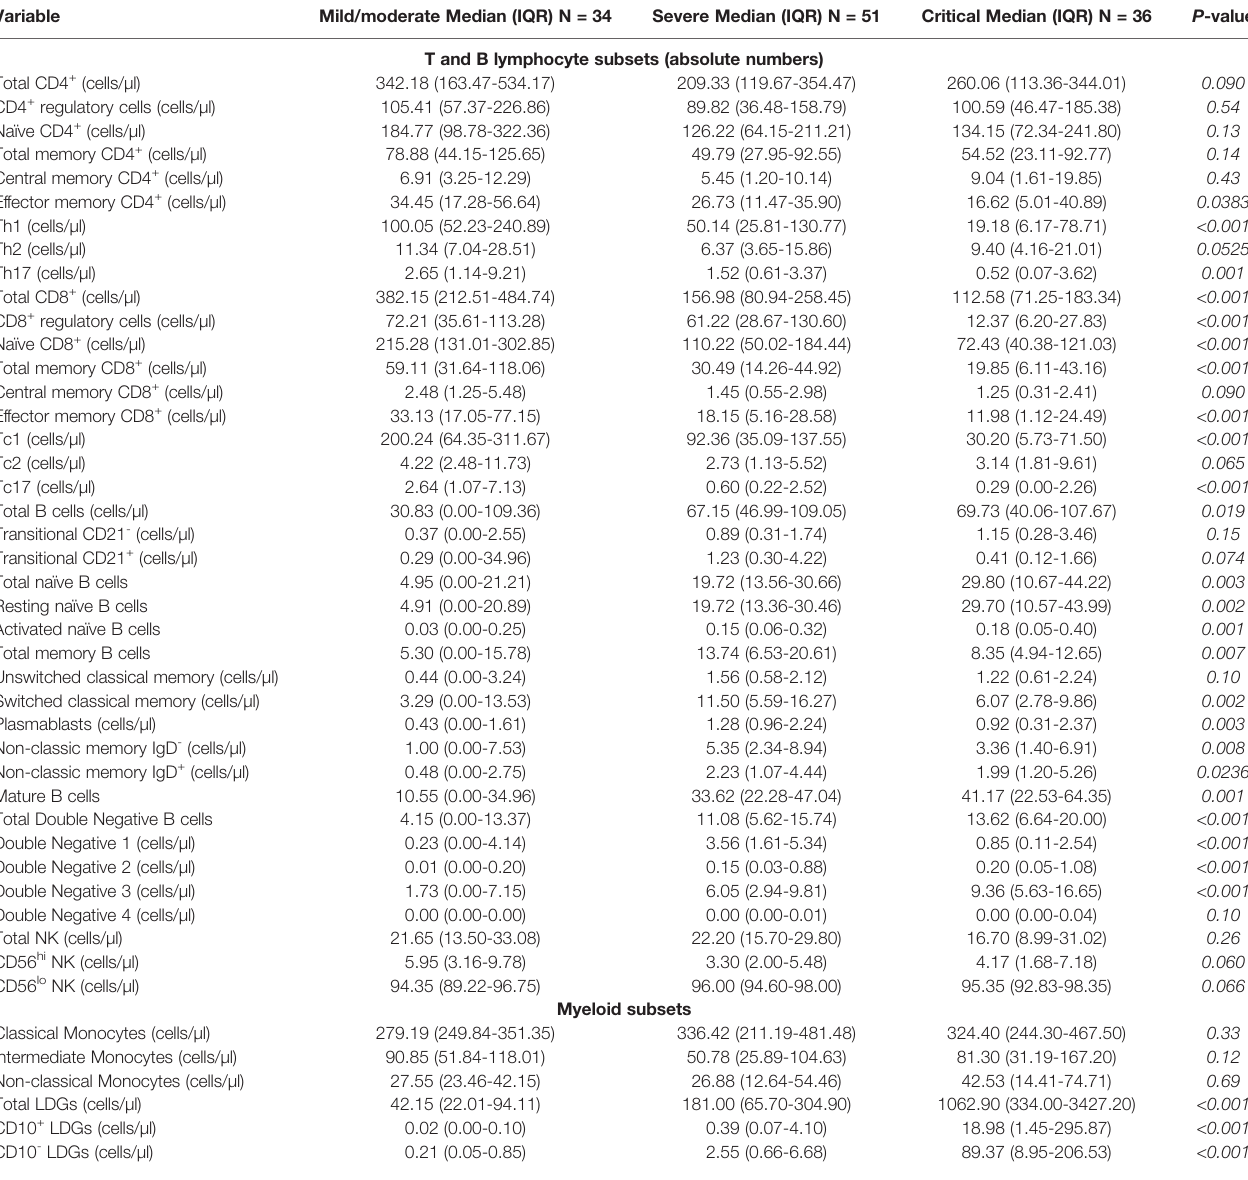
TABLE 2 | Peripheral blood cellular subsets of patients with COVID to 19 according to disease severity.